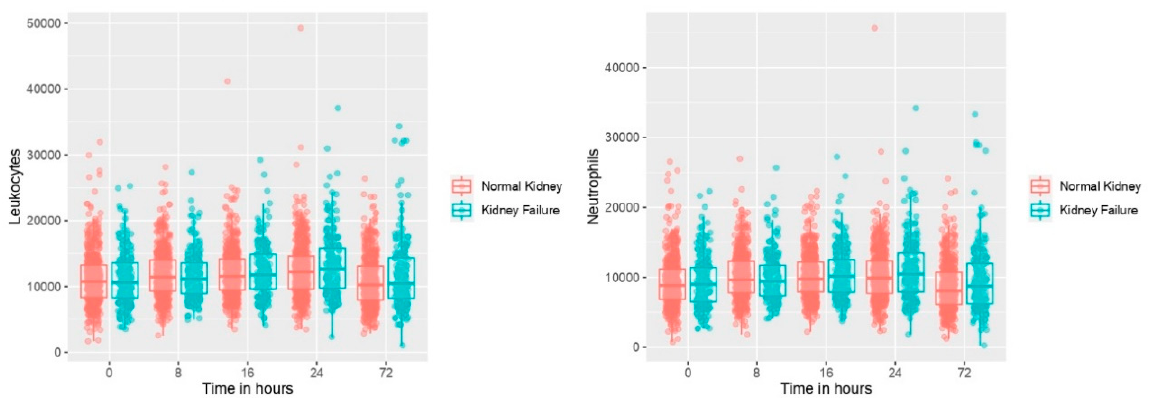
Figure 2. Box plots showing biomarker levels over time based on the presence/absence of renal failure in patients without infection.